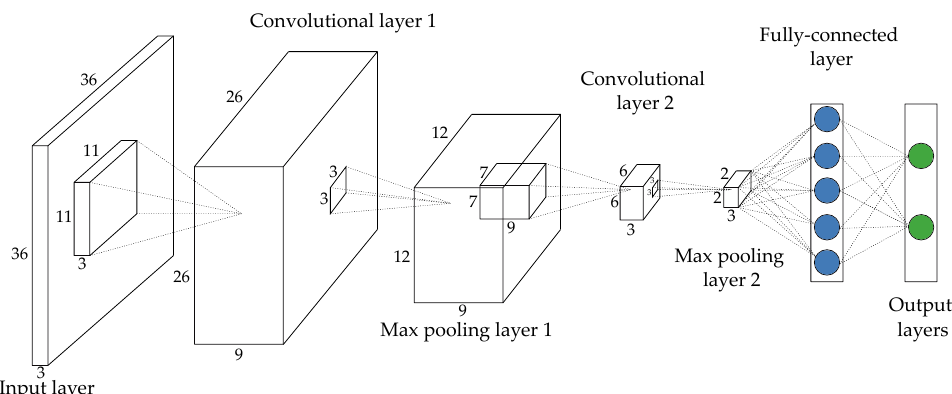
Figure 4. Schematic diagram of a typical convolutional neural